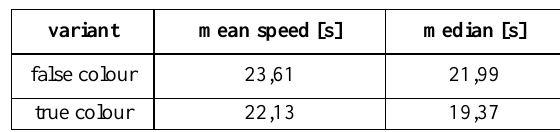
Table 2. Speed of false colour images - true colour: objects of critical